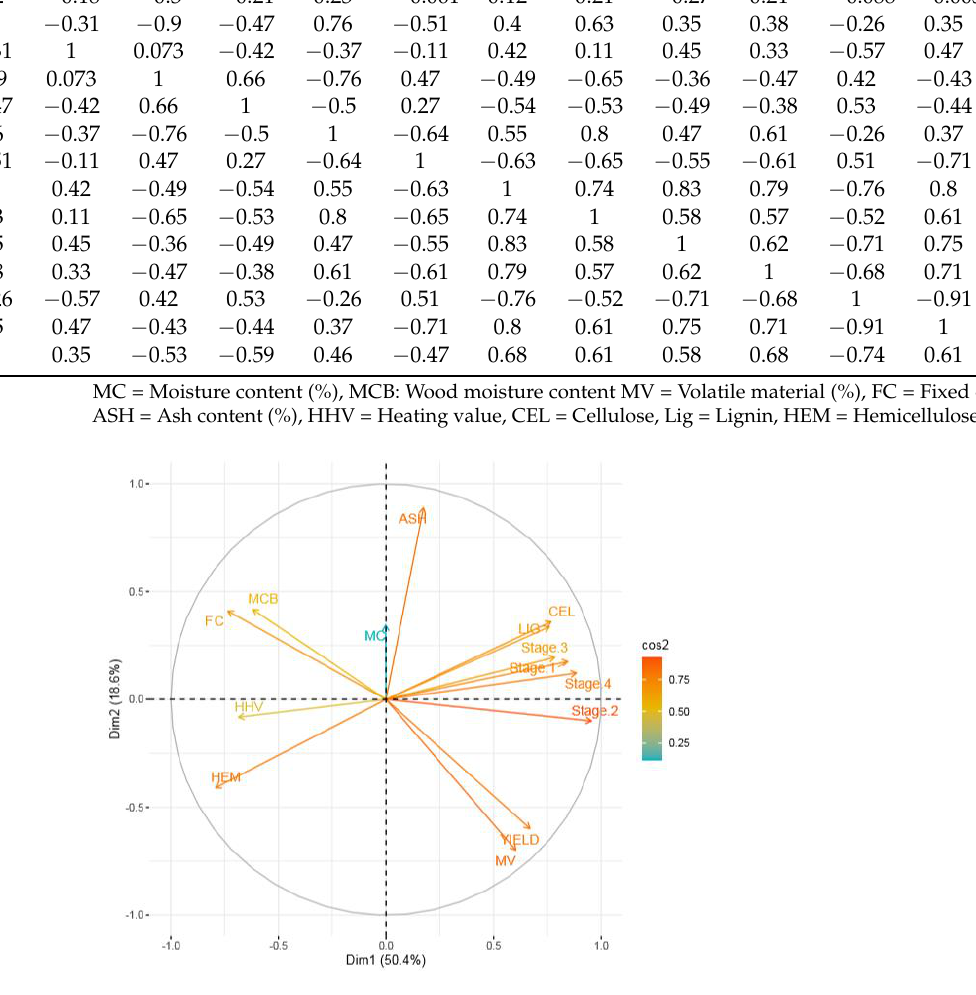
Figure 13. Principal Component Analysis (PCA), representing the two main components. MC = moisture content (%), MCB: wood moisture content MV = volatile material (%), FC = fixed carbon (%), ASH = ash content (%), HHV = Heating value, CEL = Cellulose, Lig = Lignin, HEM = Hemicelulosa.